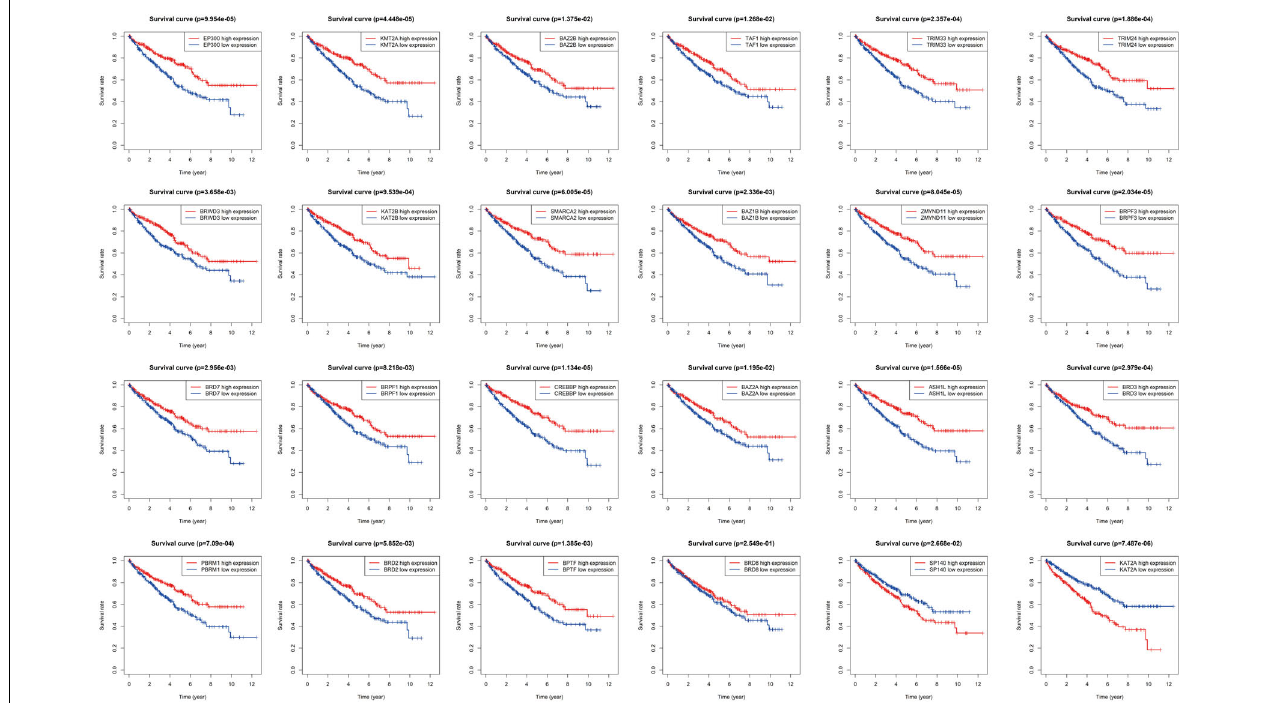
FIGURE 2 | Kaplan-Meier survival analysis for the high and low expression of BRD